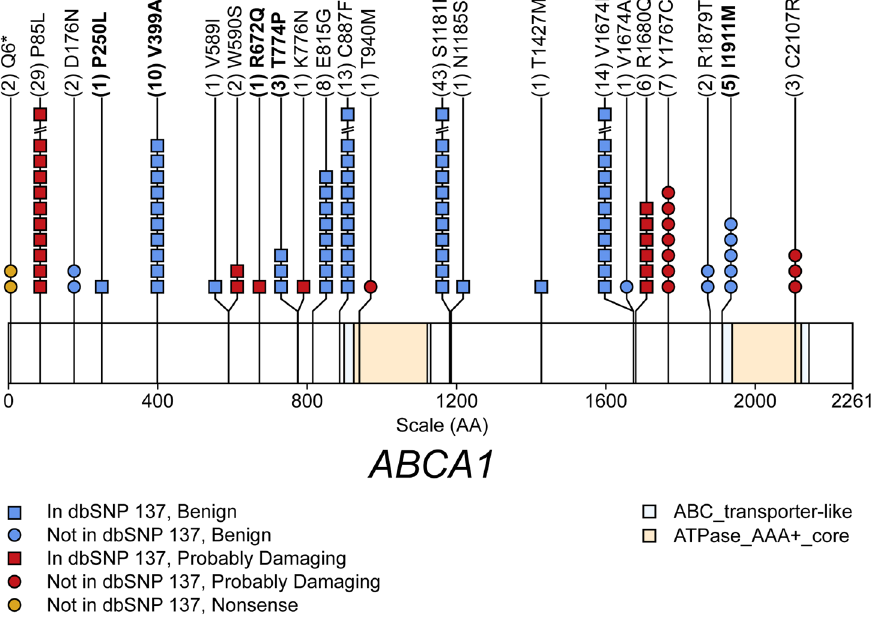
Figure 1. Schematic of rare (MAF , 1%) non-synonymous variants used in the gene-level test of total cholesterol (TC) in gene ABCA1 . The x-axis scale (AA) is in amino acid positions. Numbers in parenthesis are the number of copies of the rare variant in persons with phenotype data. The mean TC level in persons possessing variants with bold naming is increased relative to persons without the variant, for all other variants the mean TC level in persons possessing variant alleles is decreased relative to persons without the variant.